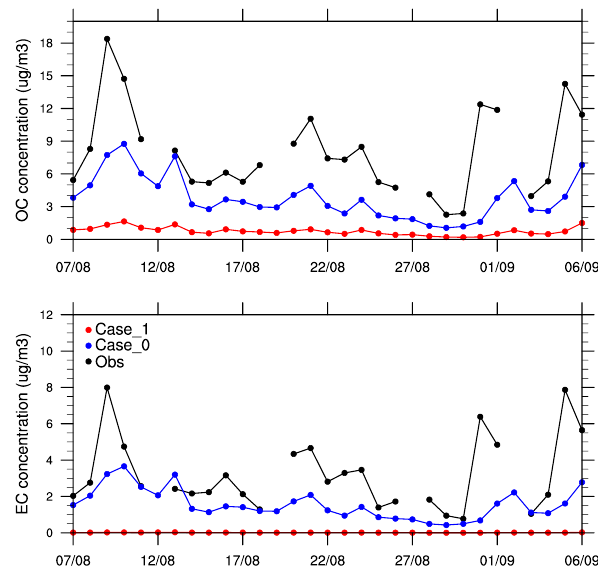
Figure 14. The observed and predicted daily variations of OC and EC concentrations at